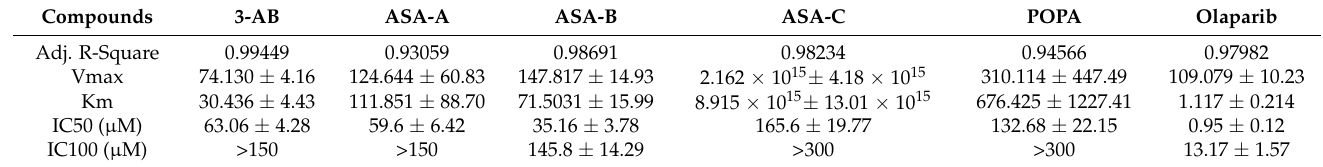
Table 3. Michaelis Menten’s model kinetics data ( ± SEM) (of PARP (0.6 units/well) inhibition-induced by the 3-aminobenzamide (3-AB), B-lactam (dehydroepiandrosterone-derived) steroid alkylator ASA-A, B,D-bilactam (dehydroepiandrosterone-derived) steroid alkylator ASA-B, B-lactam (cholesten-derived) steroid alkylator ASA-C, alkylating component POPA and Olaparib. Compounds 3-AB ASA-A Adj.